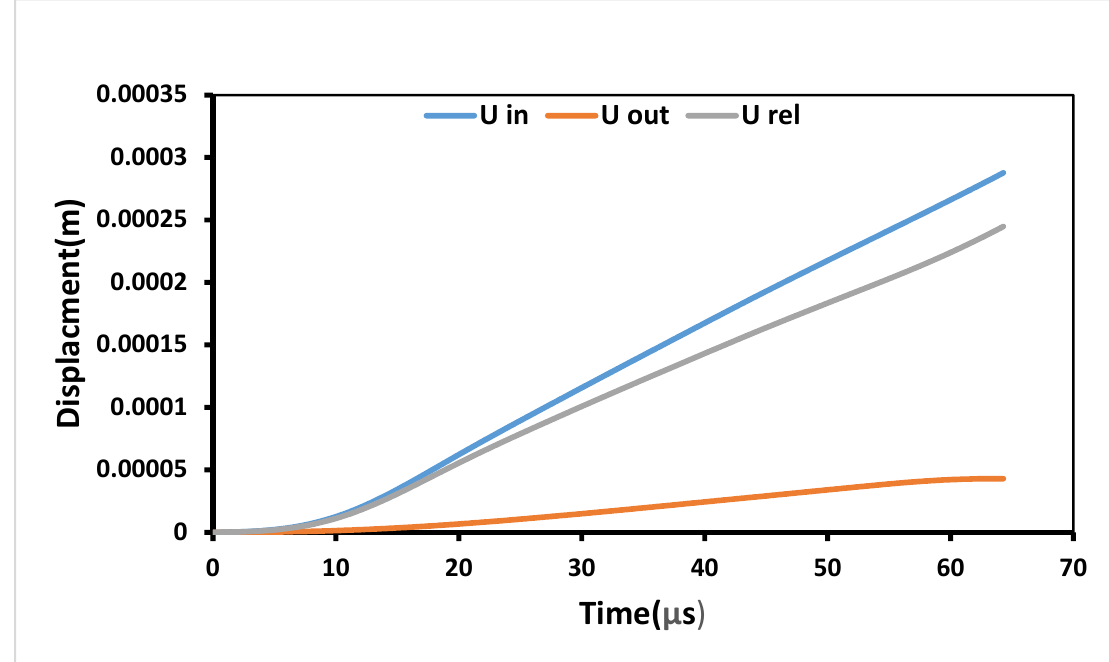
Metals 2019 , 9 , x FOR PEER REVIEW Figure 7. Displacements of the two sides of the NSSS. Figure 7. Displacements of the two sides of the NSSS.